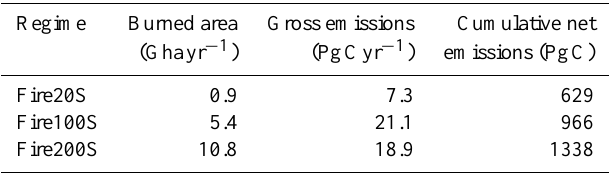
Table 2. Burned area and emissions ∗ for the three stable fire